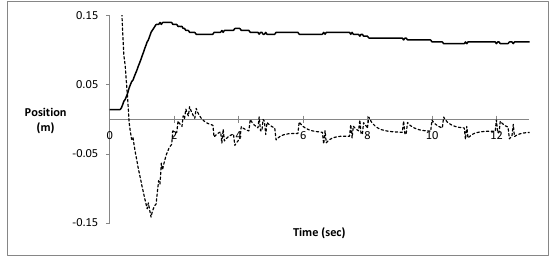
Figure 29: Tuned step response for linear P‐D control Figure 28. Experimental, tuned step response for linear PD control.